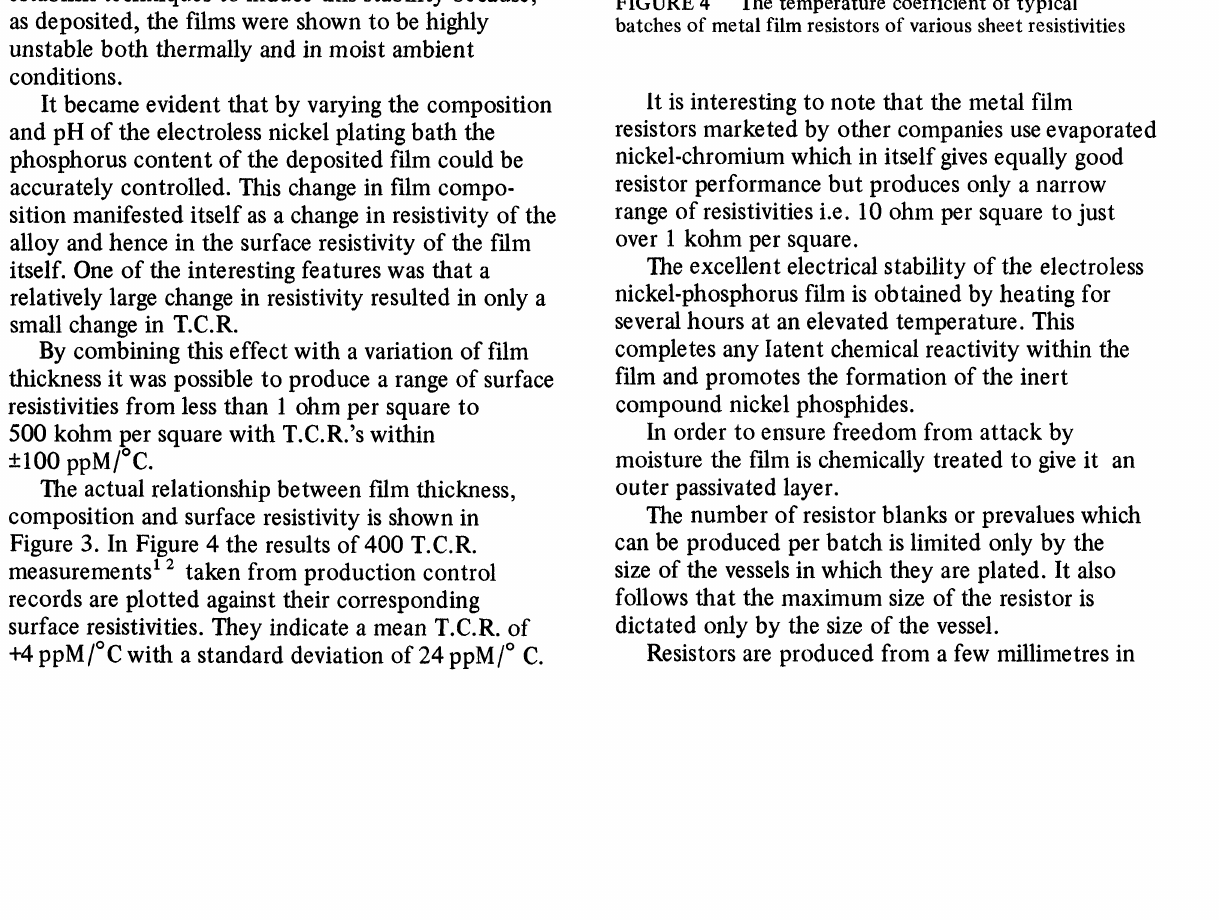
The temperature coefficient of typical batches of metal film resistors of various sheet